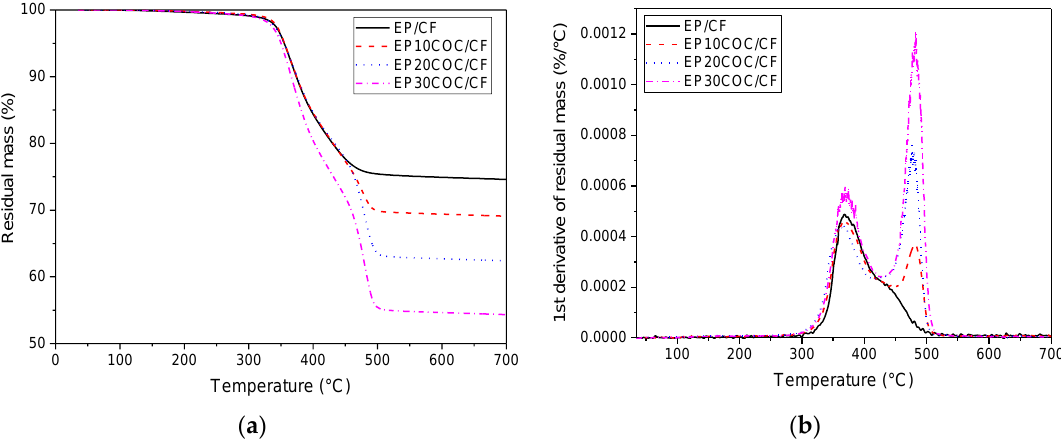
Figure 4. Thermogravimetric analyses (TGA) analysis of EP / CF and EPxCOC / CF composites (x = 10–30 wt.%). ( a ) Residual mass and ( b ) derivative of the mass loss. Table 1. Results of TGA tests on EP-CF and EPxCOC / CF laminates (x = 10–30 wt.%).